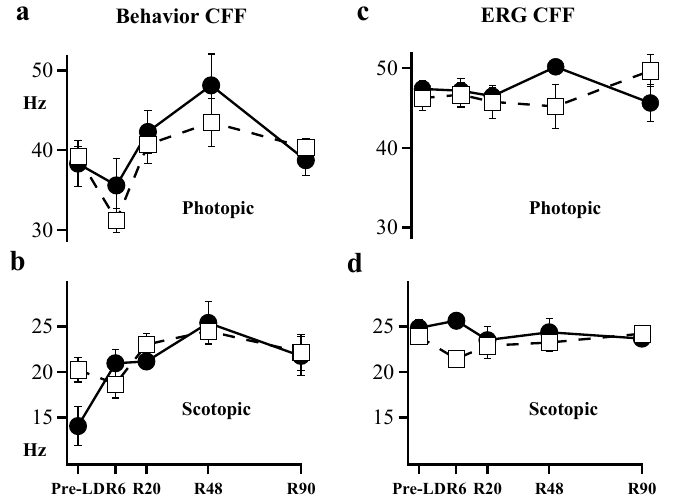
Figure 4. Behavior CFF was measured using ( a ) photopic intensity and ( b ) scotopic intensity. ERG CFF was also measured under ( c ) photopic and ( d ) scotopic intensities. Filled circles connected by solid lines show results for control animals ( n = 3 to 6). Open squares connected by dashed lines show results for light-damaged animals ( n = 5 to 10). Error Bars = ± SEM; where absent error bars are within the data marker.